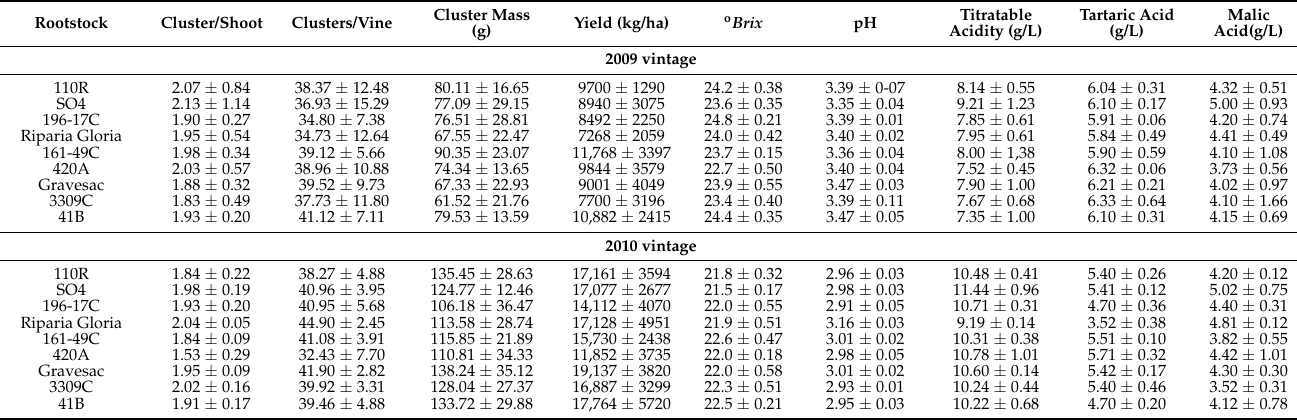
Table 2. Yield components and must composition attributes for Albariño wine grapes from different rootstocks, over two